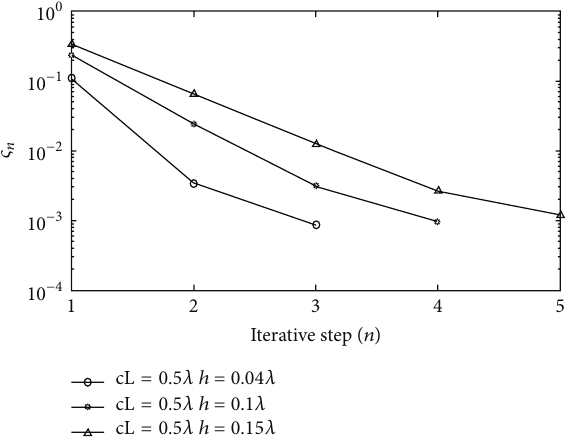
Figure 6: With different RMS height ℎ = [0.04 0.1 0.15]𝜆 , iterative deviation 𝜍 𝑛 versus iterative steps 𝑛